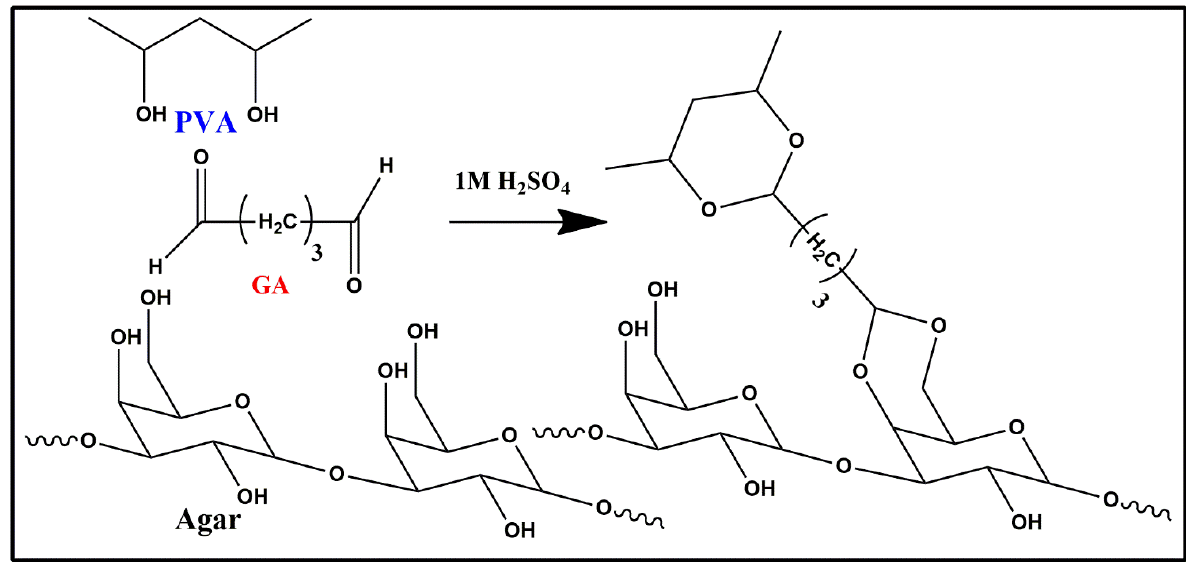
Figure 3 . The mechanism occurred among PVA, Agar and glutaraldehyde. Figure 3. The mechanism occurred among PVA, Agar and